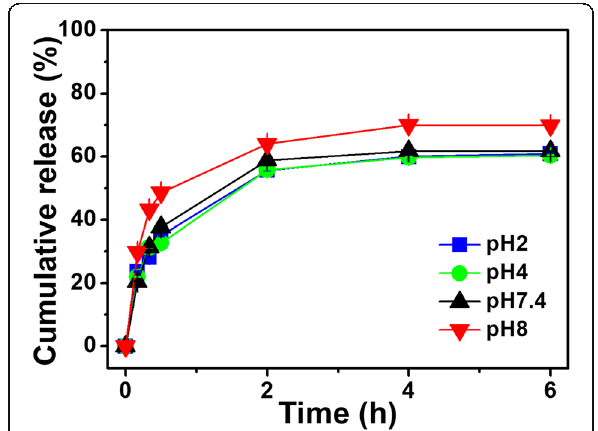
Fig. 5 Cumulative release of β -LP from PNIPAM-co-AAc20 nanogels at various pH values